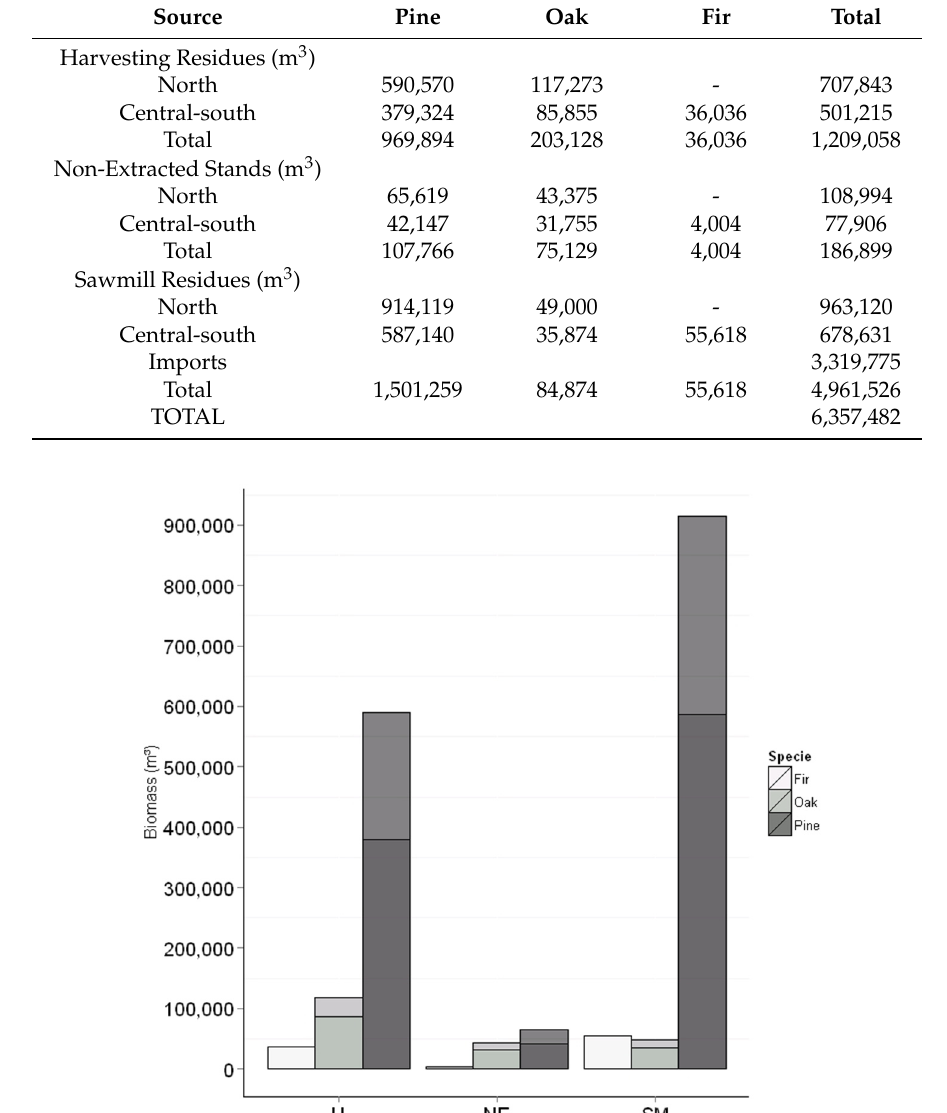
Table 1. Theoretical availability of woody biomass from harvesting residues, non-extracted volume and sawmill residues by species and region for 2013 (m 3 ).